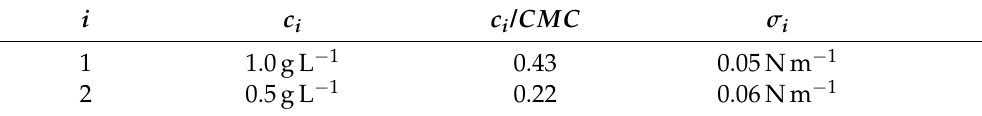
Table 1. Surfactant solution of sodium dodecyl sulfate (SDS) in tap water: concentration c i and in relation to the critical micelle concentration CMC = 2.3gL − 1 [44] as well as the corresponding surface tension σ i [45,46] at room temperature ( θ = 20°C).